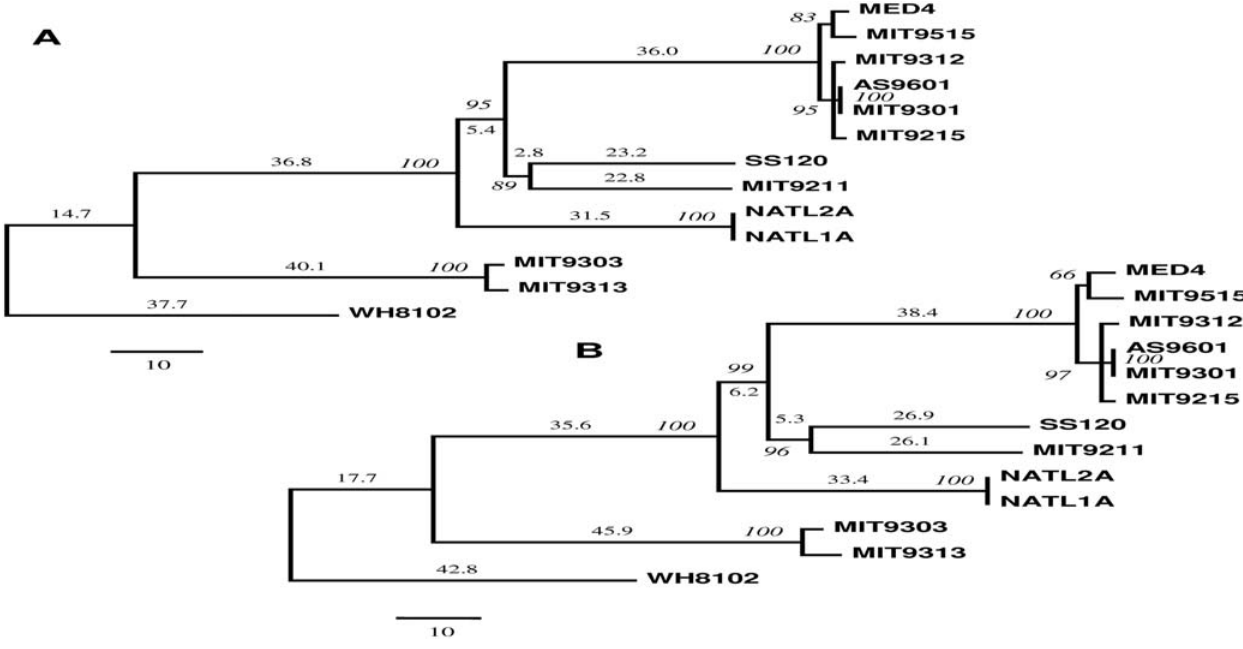
Figure 2. Phylogeny of 12 Prochlorococcus genomes inferred from (A) an empirically derived estimator (EDE) inversion distance and (B) a breakpoint distance matrix tree. Values at nodes show the number of times the clade defined by that node appeared in the 100 jacknife trees. Values above branches and the scale bar show number of genome rearrangement events. The Synechococcus WH8102 is used as an outgroup.